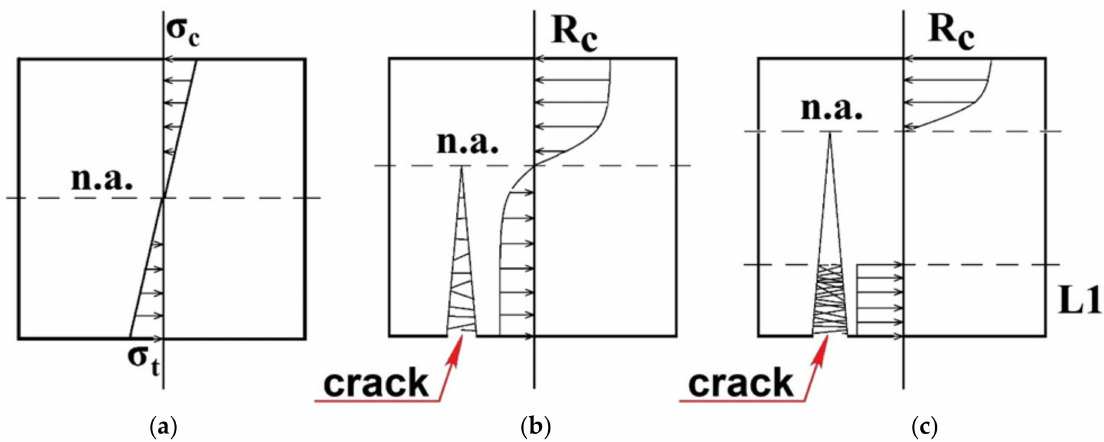
Figure 24. Distribution of stresses in the bended SFRC beam: ( a ) without crack; ( b ) with a macro-crack in the concrete with homogeneously distributed fibers (Group 1); ( c ) with a macro-crack and one layer with fibers (Group